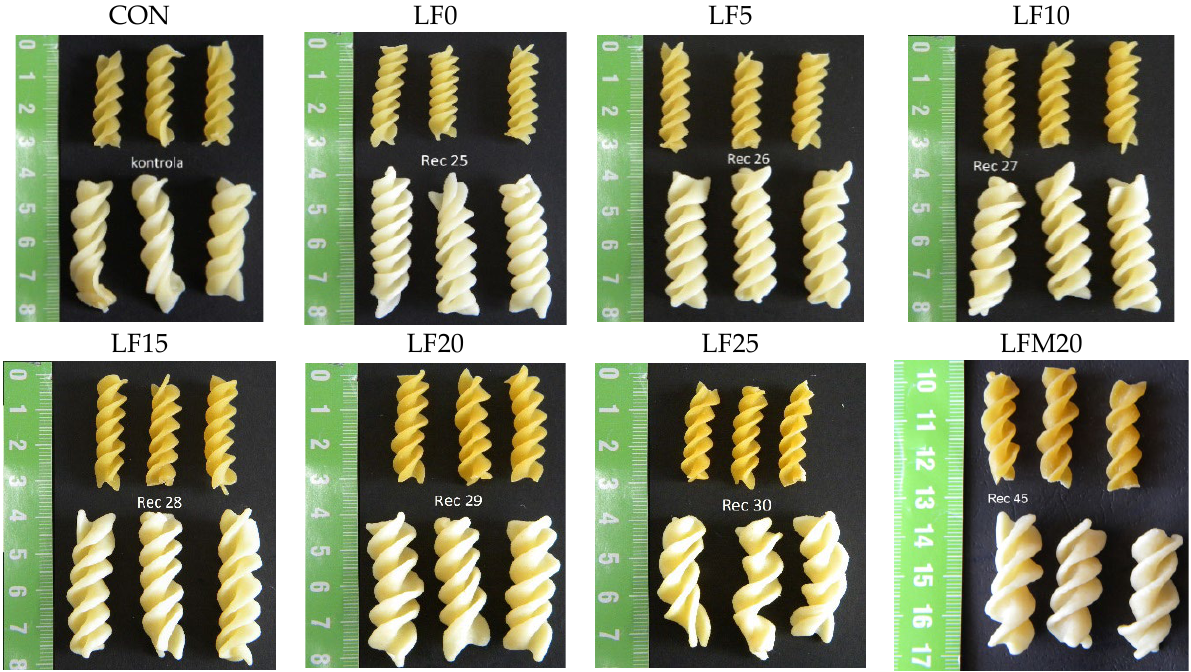
Figure 1. Uncooked (above) and cooked (below) pasta samples; Explanation: CON, control sample; LF, lupin flour; LFM, lupin flour and millet. The addition of lupine flour up to 25% did not produce an increase in the pasta volume index. The differences in the weight increase index in most of the studied samples were statistically